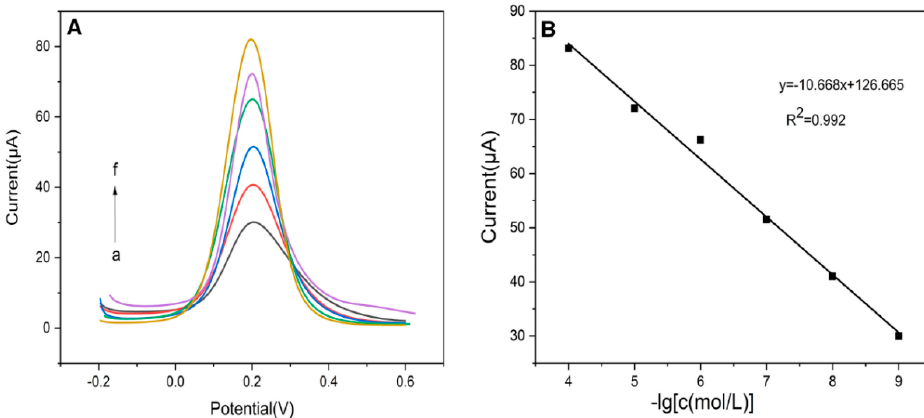
Figure 12. ( A ) DPV of IIP electrode after elution in different concentration of Cd 2+ and ( B ) calibration curve. Reprinted with permission from Ref. [123]. Copyright 2021, the Springer Nature.